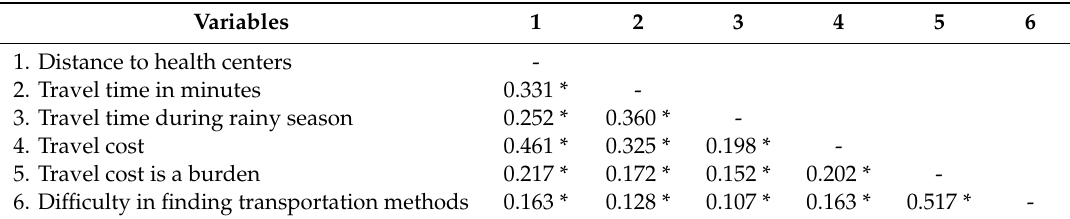
Table 5. Correlations between distance to health centers and independent variables ( N = 994).